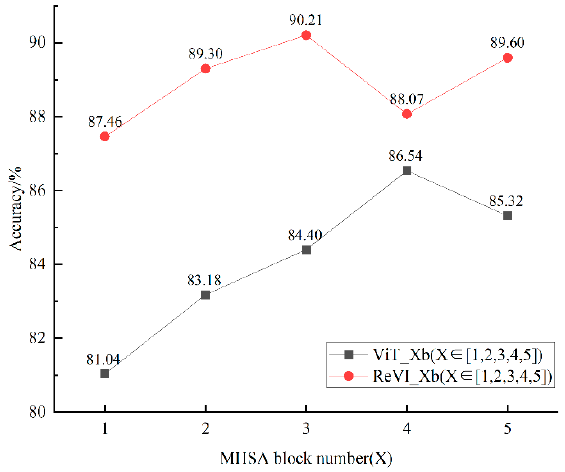
Figure 9. Prediction accuracy of ViT_Xb ( X ∈ [ 1,2,3,4,5 ]) and ReVI_Xb ( X ∈ [ 1,2,3,4,5 ]) on the test dataset.